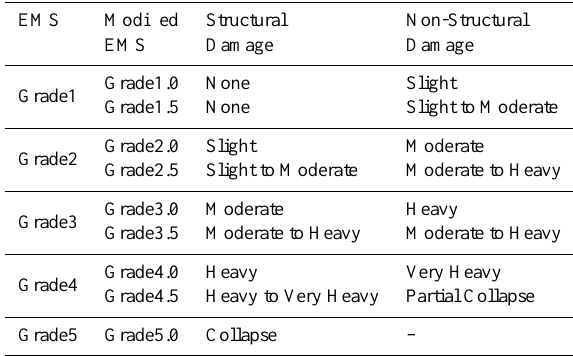
Table 1. The definition of EMS and modified EMS grades used in the study.